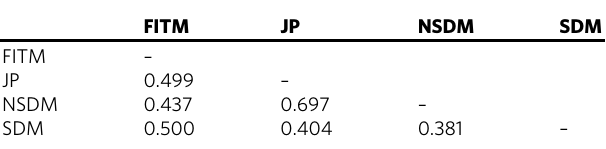
Table 4 Discriminant validity (Hetrotrait – Monotrait ratio (HTMT).